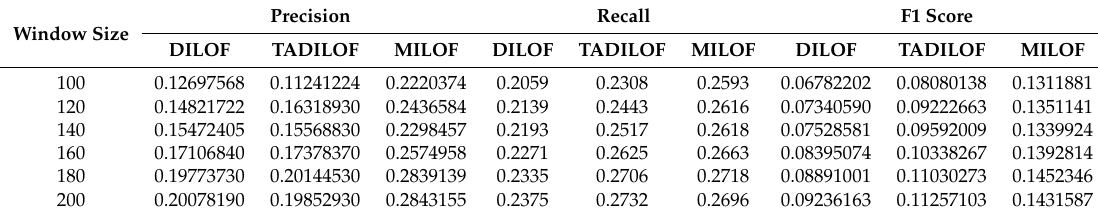
Table 4. Precision, recall, and F1 score on Letter Recognition dataset.